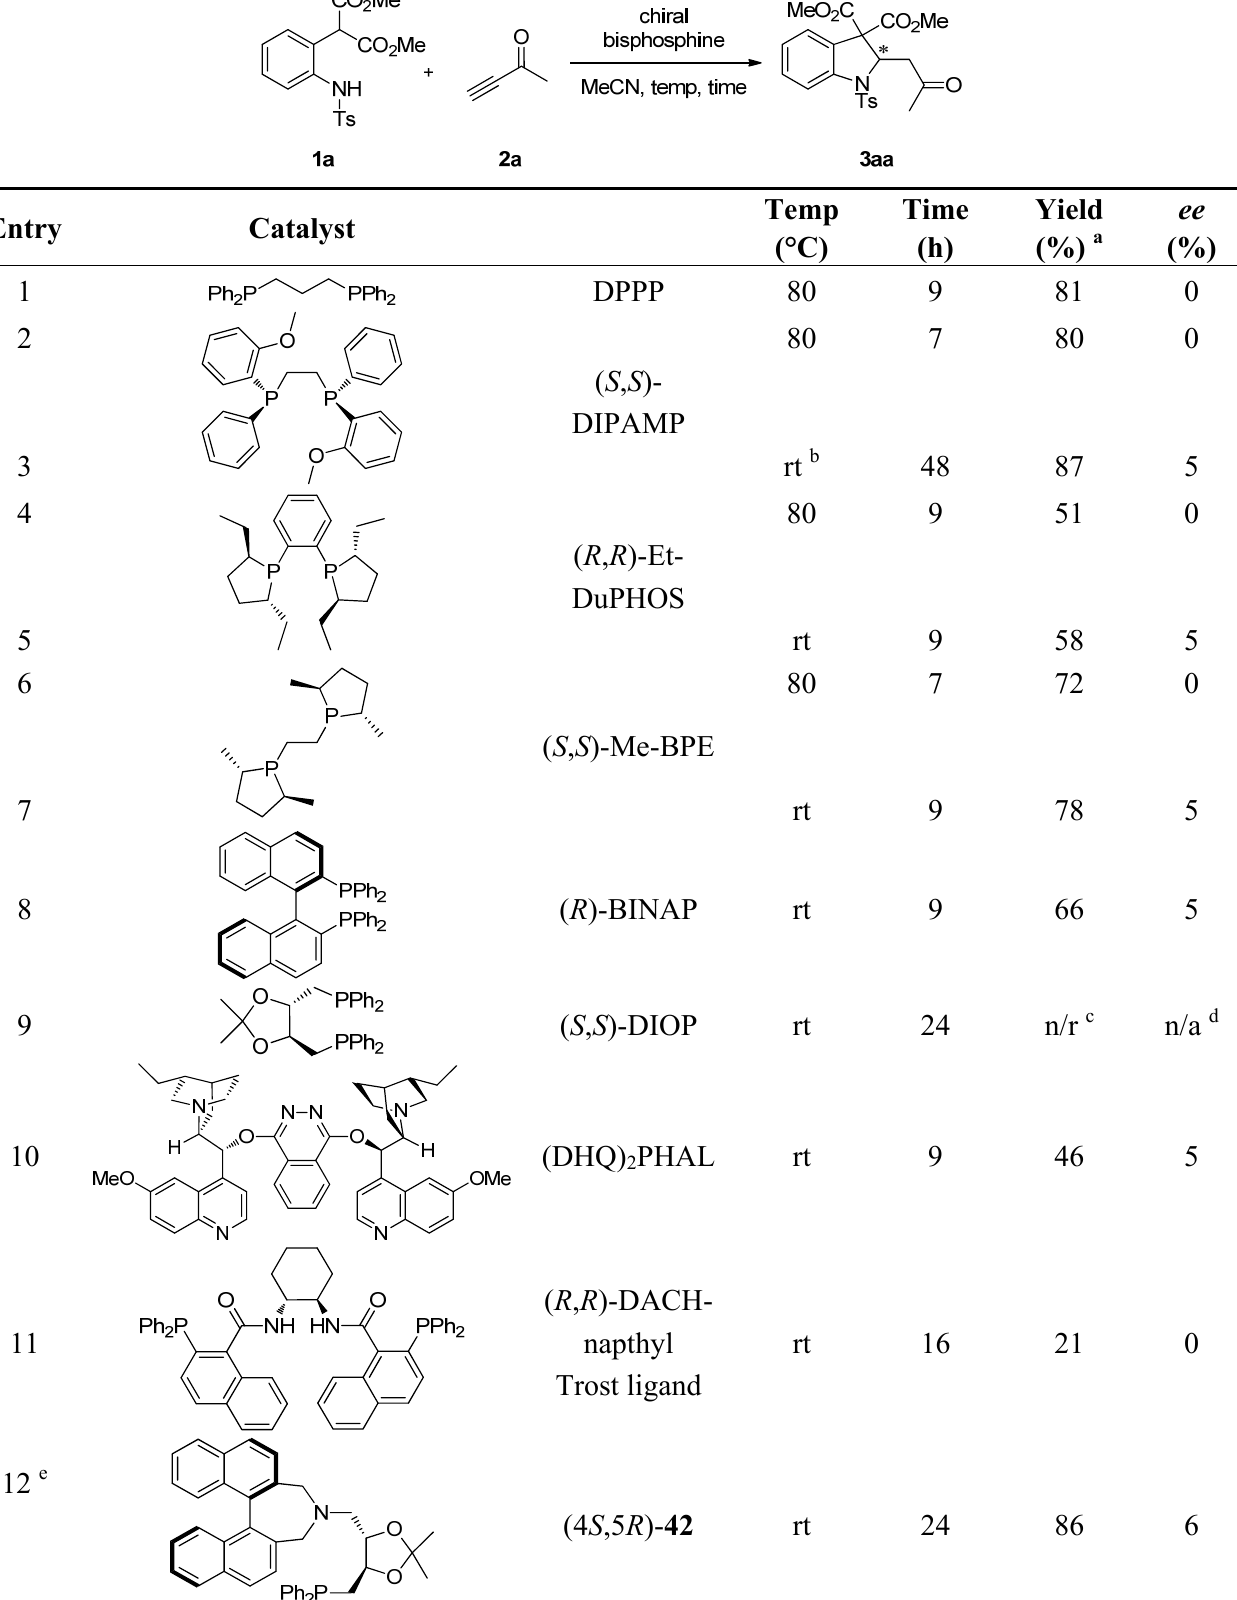
Table 1. Preliminary screening with commercially available chiral bisphosphines